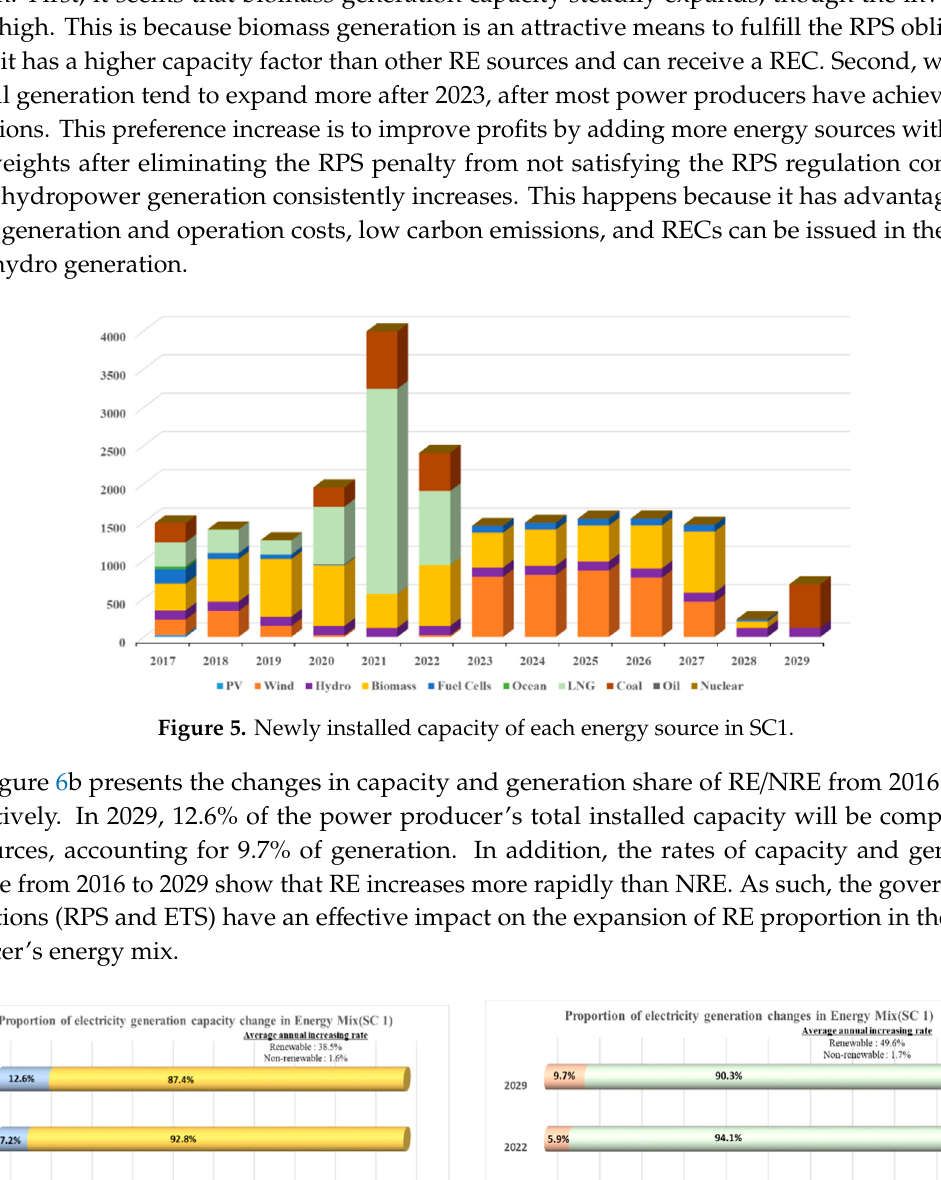
Figure 6. The proportion of RE/NRE capacity and generation. ( a ) Trends in the proportion of RE/NRE capacity (SC1); ( b ) trends in the proportion of RE/NRE generation (SC1). (RE: Renewable Energy, NRE: Non-renewable Energy)